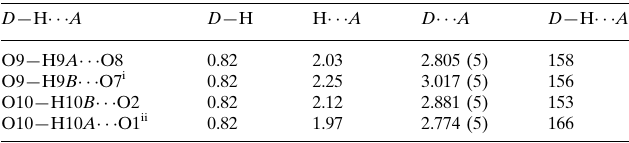
Hydrogen-bond geometry (A˚ , (cid:3)